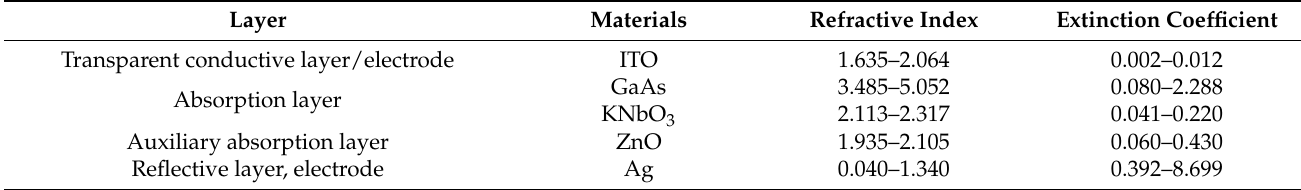
Figure 2. ( a ) Schematic structure of the solar cell. ( b ) Schematic structure of the photonic crystal absorption layer. ( c ) Schematic structure of the hexagonal scattering element. ( d ) Schematic structure of the square scattering element. Table 1. Optical parameters of the materials used in each layer of the solar cell.